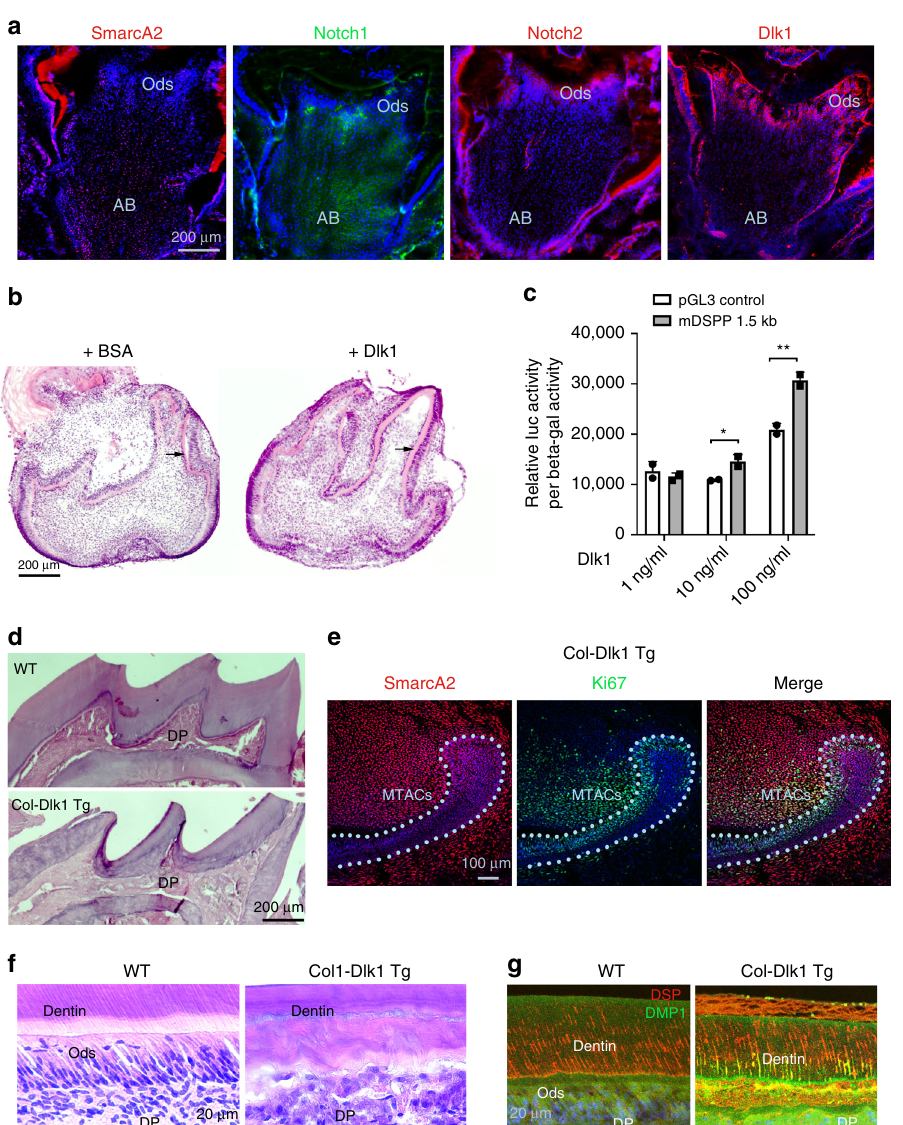
Fig. 8 Dlk1 can be applied in enhancing MSCs lineage differentiation. a Immuno fl uorescence analysis of indicated molecules in the P7 CD1 mouse fi rst lower molars. AB apical bud, Ods odontoblasts. b Representative images for organ cultures of E16.5 mouse fi rst lower molar for 4 days in the absence or presence of Dlk1. Black arrows indicate dentin layers. Note the increased deposition of dentin in the Dlk1-treated samples. c Mouse DSPP promoter luciferase analysis in the MO6-G3 cells after receiving Dlk1 treatment at different concentrations. * p < 0.05; ** p < 0.01. Genomic DNA were extracted from n = 3 biologically independent samples. Paired Student ’ s t-test was performed. No asterisk: p > 0.05; * p < 0.05; ** p < 0.01. d H&E images of the upper tooth crowns of the WT vs. Col-Dlk1 Tg mouse fi rst lower molars. Note the mutant mouse ’ s dental pulp (DP) is fully mineralized. e SmarcA2 and Ki67 double staining on Col-Dlk1 Tg mouse incisor at P7. Light blue dotted lines indicate epithelial – mesenchymal junctions. f , g H&E ( f ) and immuno fl uorescence analysis ( g ) of WT vs. Col-Dlk1 Tg mouse incisor labial dentin and tooth pulp. Error bars represent standard deviation. Bars: a , b and d : 10 μ m; e : 100 μ m; f , g : 20 μ